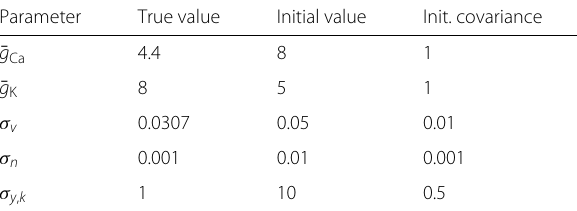
Table 2 True value, initial value, and covariance of the parameters in Fig.